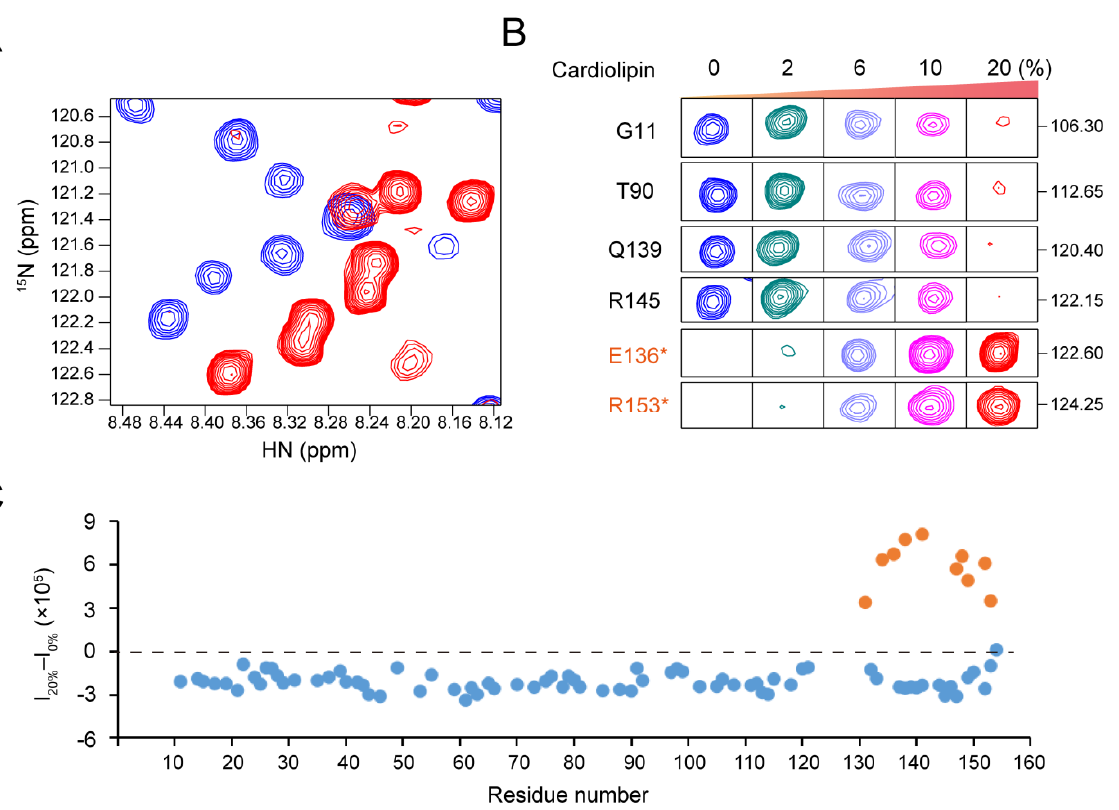
Figure 1. Negatively charged lipids promote the membrane-association of MLKL 2–154 . ( A ) The overlaid 2D 1 H- 15 N TROSY- HSQC spectra of MLKL 2–154 in DMPC bicelles with (red) and without (blue) 20% cardiolipin. ( B ) The peak of six residues of MLKL 2–154 in DMPC bicelles supplemented with different concentrations of cardiolipin. The first left panel shows the same spectral region as the right panels for each residue. Panels 2–5 are spectra-recorded at increasing concentrations of 2%, 6%, 10%, and 20% cardiolipin. Residue names marked by an asterisk and colored in orange are new resonances which appeared upon the addition of cardiolipin. ( C ) Peak intensity changes (I 20% –I 0% ) between MLKL 2–154 in DMPC bicelles with (I 20% ) and without (I 0% ) 20% cardiolipin. The orange dots denote the newly emerged resonances. The assignment of resonance peaks was conducted as described